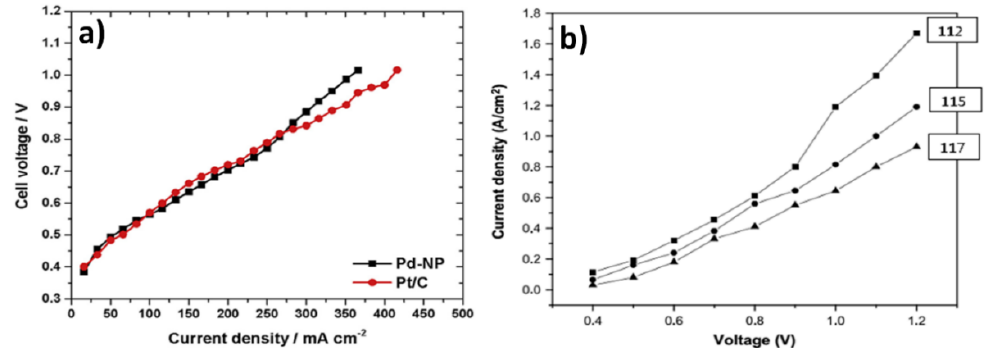
Figure 8. ( a ) Polarization curve of Pd nanoparticles and 20 wt% Pt / C. ( b ) Dependence of membrane electrolyte thickness on current the density of methanol electrolyzer. Adapted with permission from [65], copyright 2016.